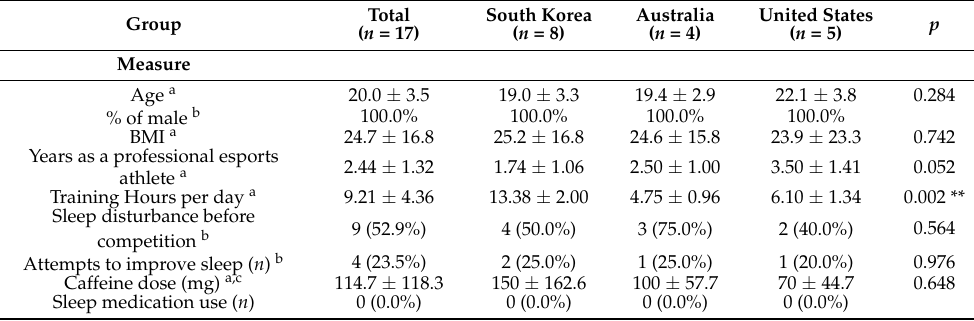
Table 1. Characteristics of the study